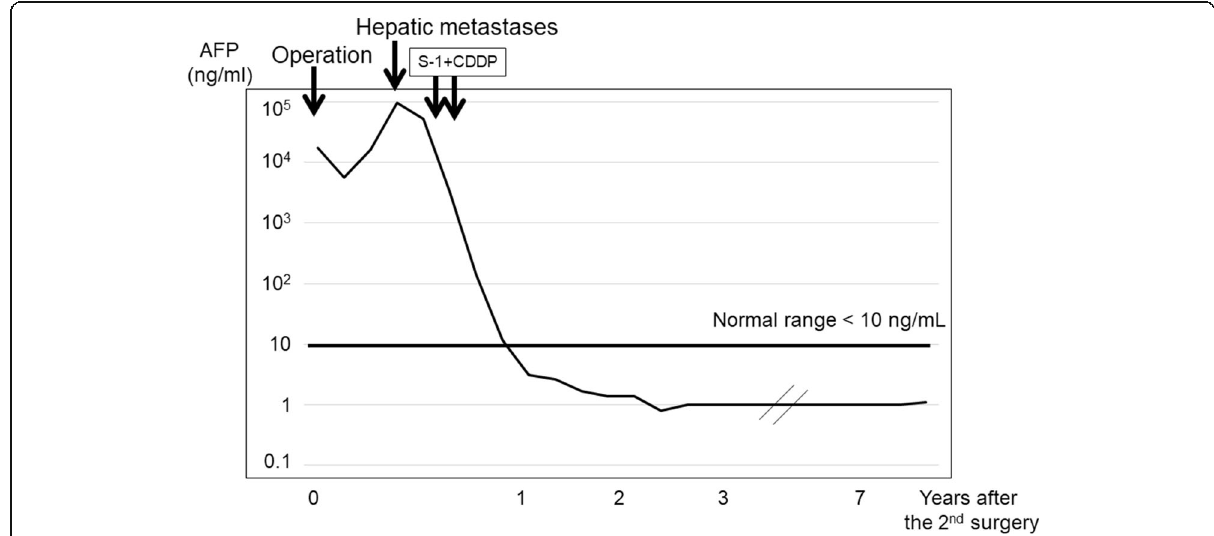
Fig. 4 Clinical course and levels of serum alpha-fetoprotein. AFP, alpha-fetoprotein; CDDP